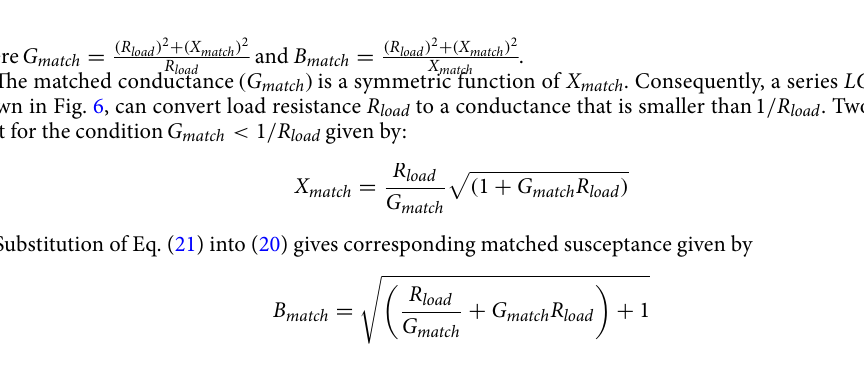
Figure 7. Variable parallel LC -network and its matched admittance Y match